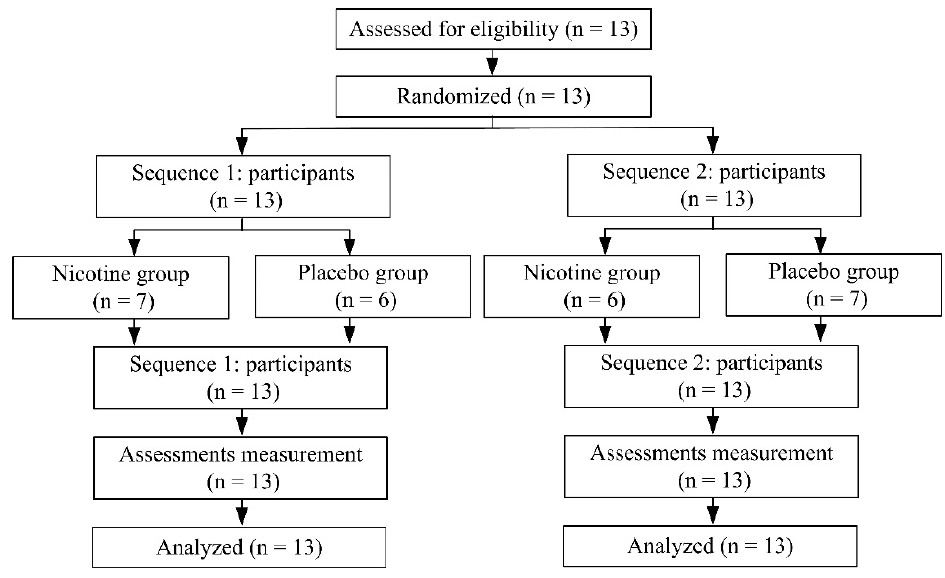
Figure 2. Participants disposition. Table 1. All participants’ demographics.